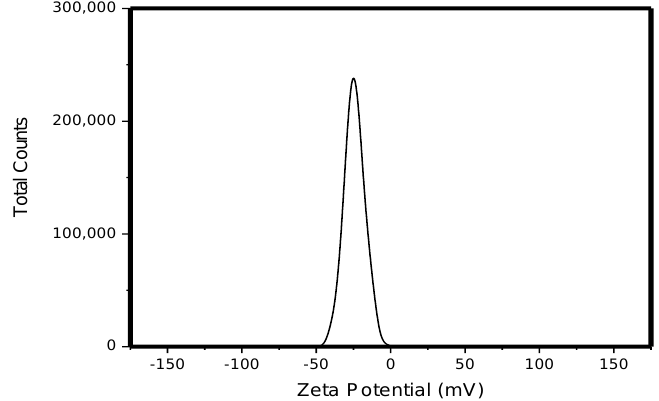
Figure 3. Zeta potential distribution of AgNPs.